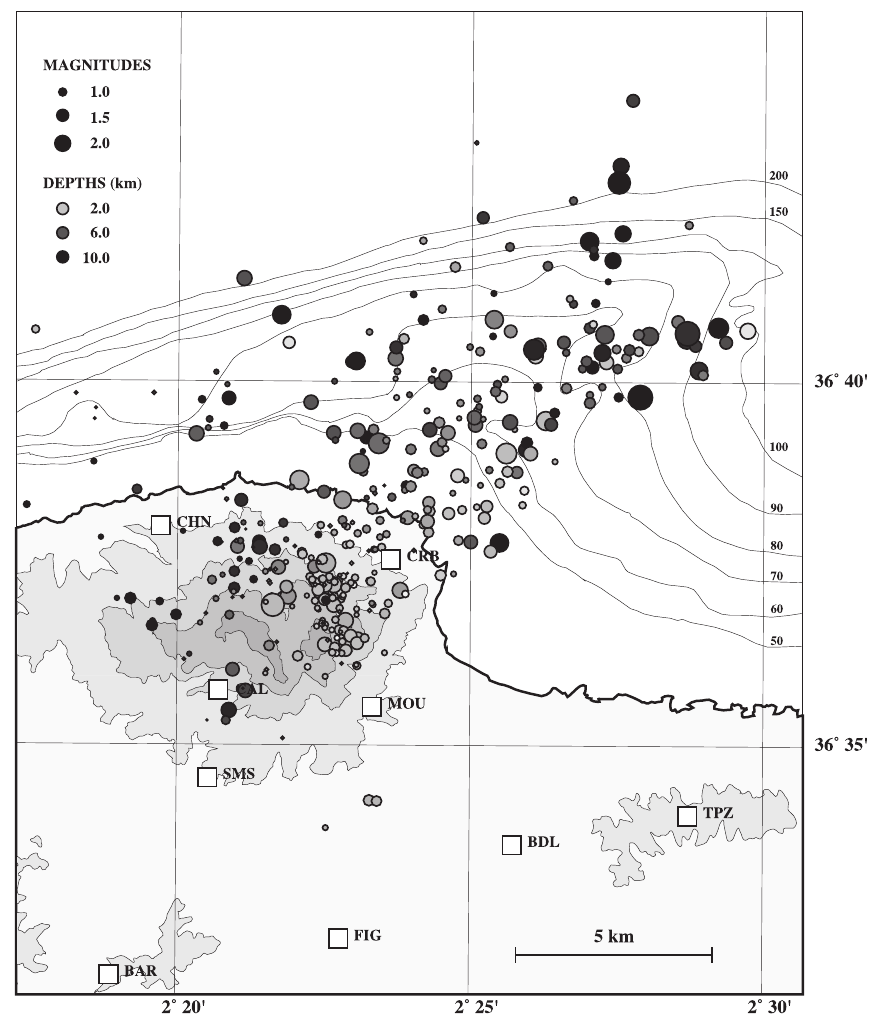
Fig. 6. Map view of the epicenters of the aftershocks. Open squares: seismological